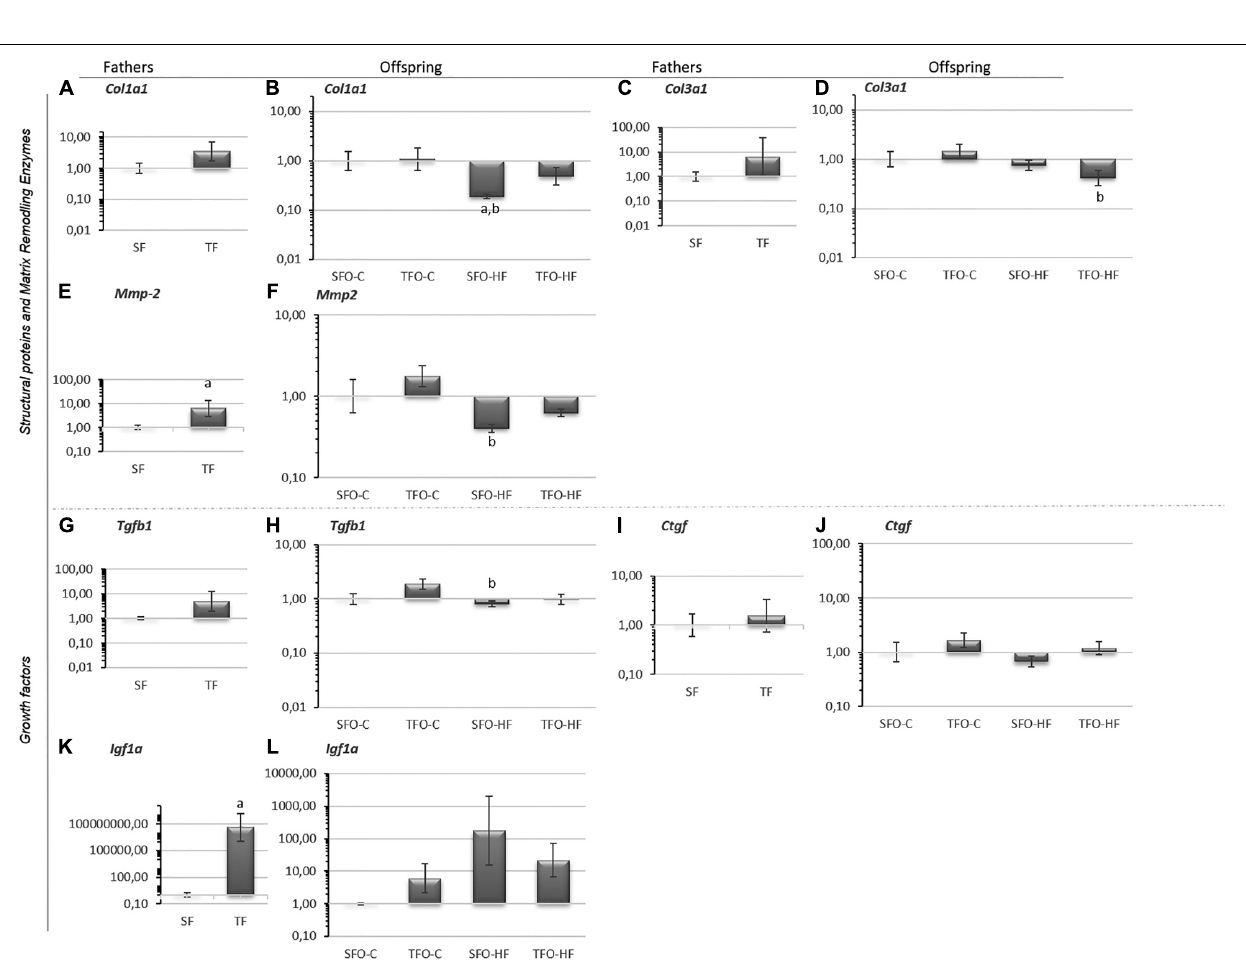
FIGURE 2 | Structural matrix proteins, matrix remodeling enzymes, and growth factor. mRNA levels in the gastrocnemius muscle of fathers and offspring exposed to control diet and HFD. The data are geometric mean ± standard error. The 2 − (cid:49)(cid:49) CT represents the expression level. (A,B) Collagen, type I, alpha 1 ( Col1a1 ). (C,D) Collagen, type III, alpha 3 ( Col3a1 ). (E,F) Matrix metalloproteinase-2 ( Mmp2 ). (G,H) Transforming growth factor-beta 1 (TGF- β 1). (I,J) Connective tissue growth factor ( Ctgf ). (K,L) Pro-insulin like growth factor IA ( Igf1a ). SF, sedentary fathers; TF, trained fathers; SFO-C, offspring from sedentary fathers, exposed to control diet; TFO-C, offspring from trained fathers exposed to control diet; SFO-HF, offspring from sedentary fathers exposed to high-fat diet; TFO-HF, offspring from trained fathers exposed to a high-fat diet. Statistically significant differences compared to: a SFO-C; b TFO-C; p ≤ 0.05 ( n = 7 per